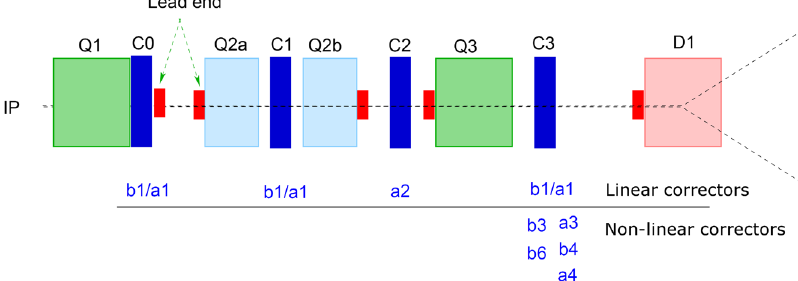
FIG. 3. Corrector layout in the LHC experimental insertions